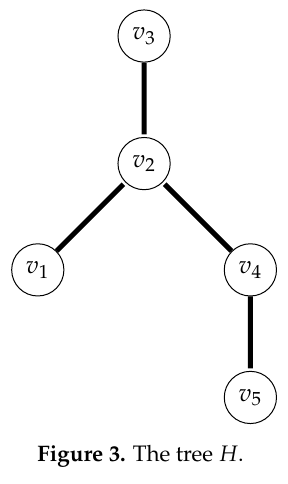
Figure 3. The tree H .